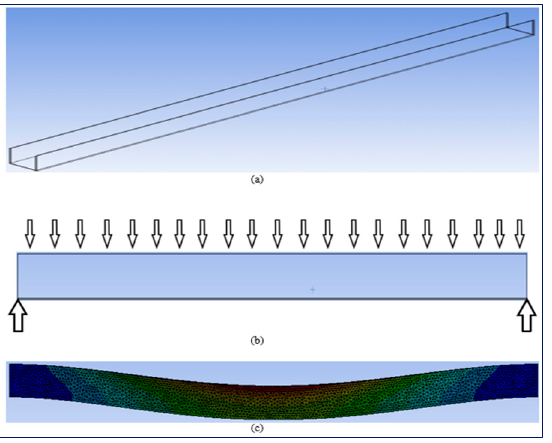
Figure 2. ( a ) Cable trough, ( b ) static load, and ( c ) static load plus dynamic load applied.